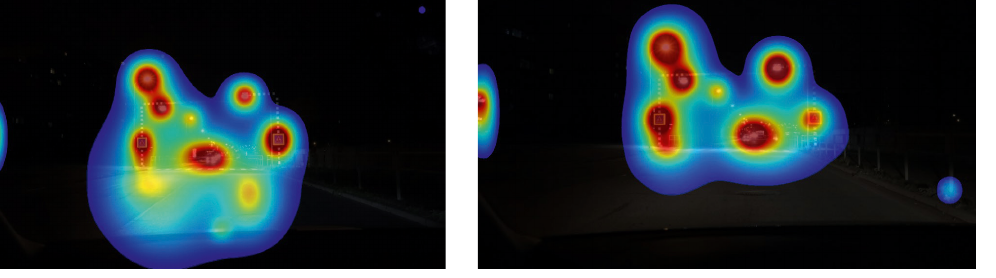
Figure 12a. 3M VAS heatmap analysis; LED lamps